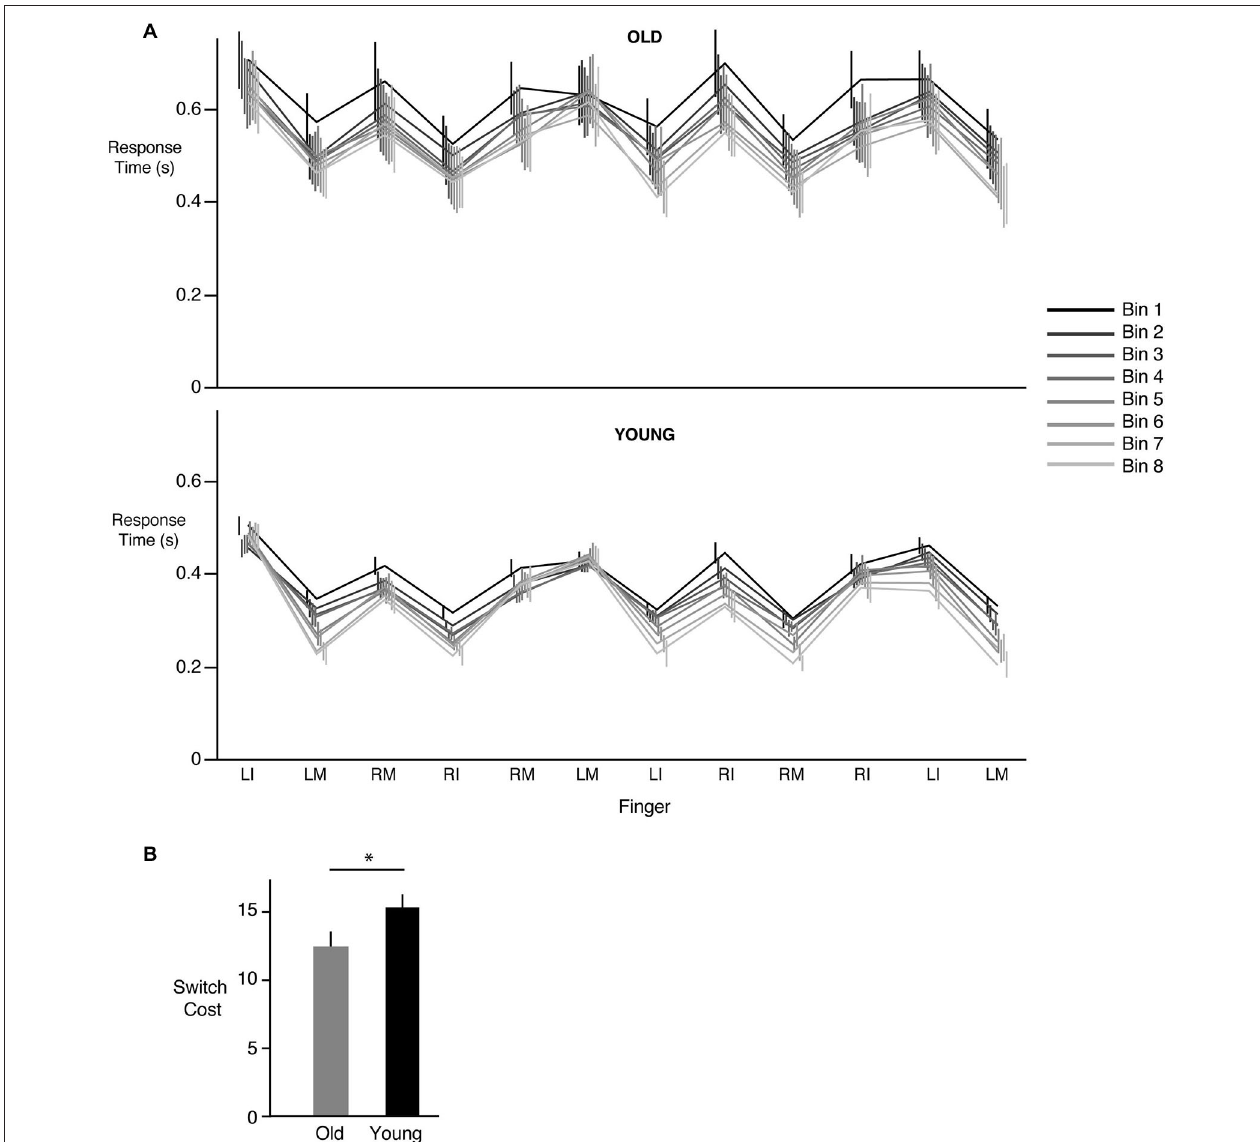
bar) lines are slightly offset from each other for better visibility. There was an increase in response time (“switch cost”) whenever a subsequent response required a change in hand (either left to right, or right to left), and this increase remained roughly constant throughout learning. However, a decrease in overall response time from bin 1 to bin 8 was seen. (B) Mean ± SE hand switch cost for the old (gray) and the young (black) groups. * = statistically